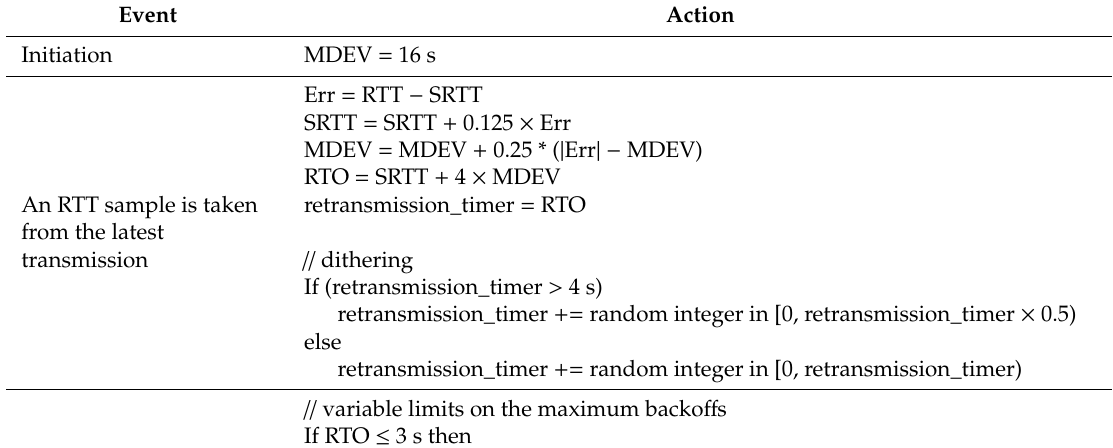
Table 2. Proposed